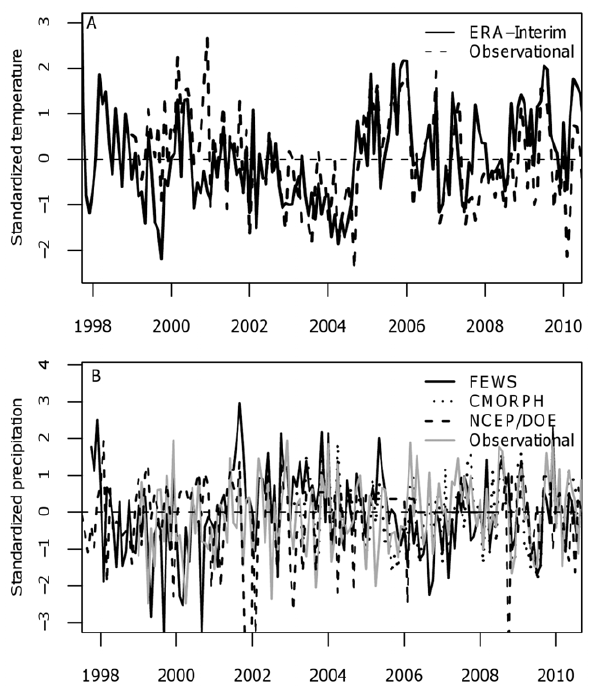
Figure 4. Variability among the different temperature and rainfall data sources. (A) Standardized monthly mean temperatures (1998- present) from the Arua airport (Observational) and ERA-Interim datasets. (B) Standardized monthly days of rainfall . 0.2 mm (1998- present) from Arua airport (Observational), National Centers for Environmental Prediction re-analysis II project (NCEP/DOE), USAID Famine Early Warning System Network (FEWS-Net), and Climate Prediction Center morphing technique (CMORPH) rainfall datasets. The other rainfall datasets were not included in the figure to maintain